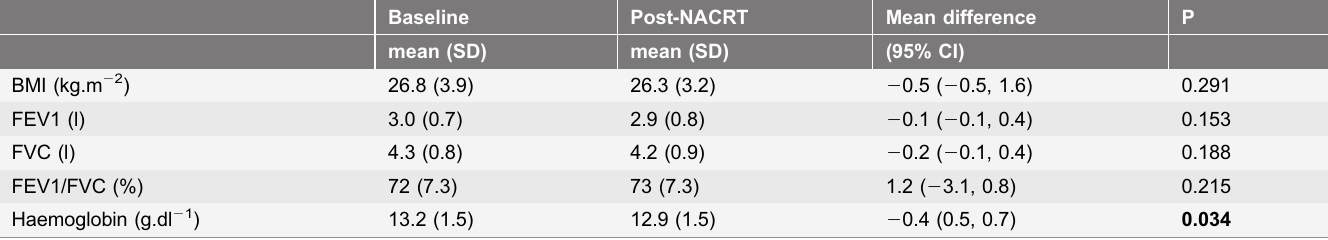
Table 2. Patient characteristics at Baseline and